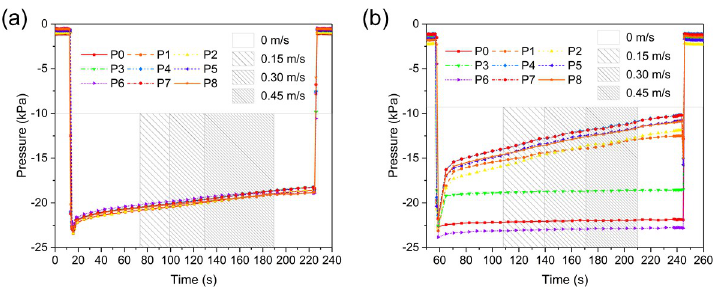
Fig 13. Suction dynamics of two adult sea lampreys showing characteristic responses in Experiment 3. (a) Suction pressures of an adult male lamprey in the flowing water test, and (b) suction pressures of an adult female lamprey in the flowing water